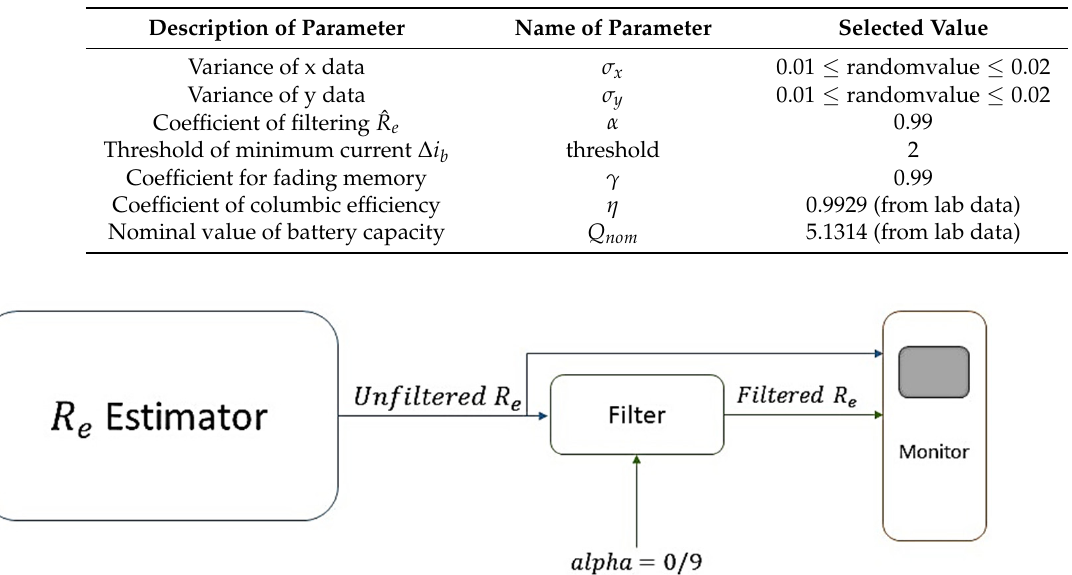
Figure 4. Re estimation diagram.